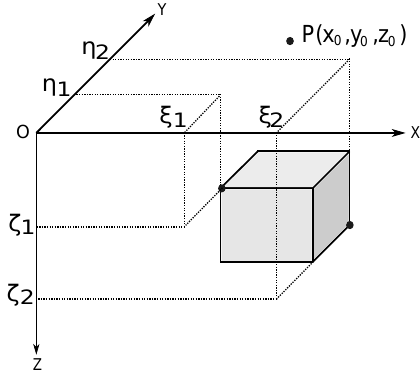
Figure 1. Differential rectangular